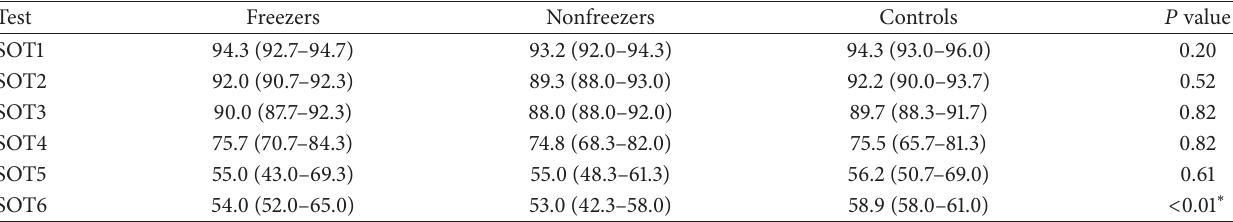
Table 2: SOT equilibrium score descriptive variables.